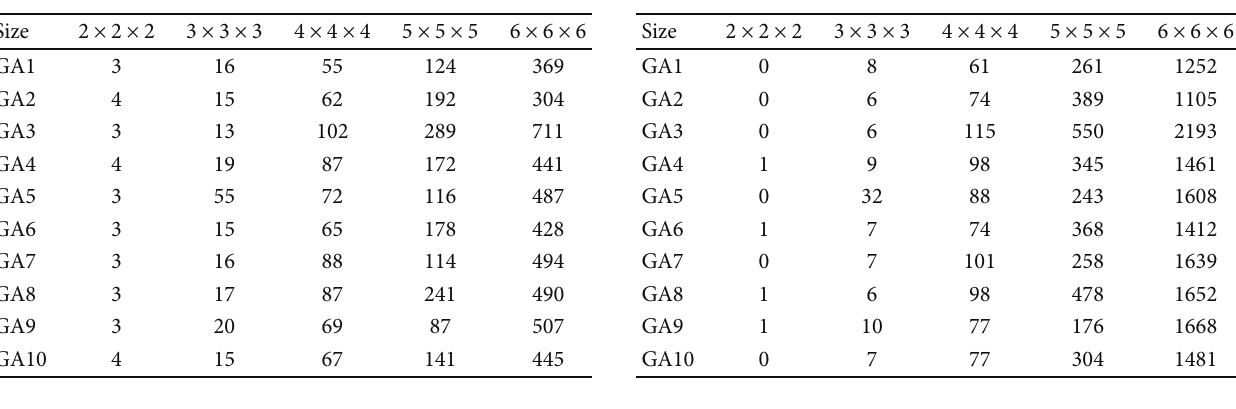
Table 6: Calculation time (s) with 200 macros. Table 4: Number of used genetic algorithms with 200